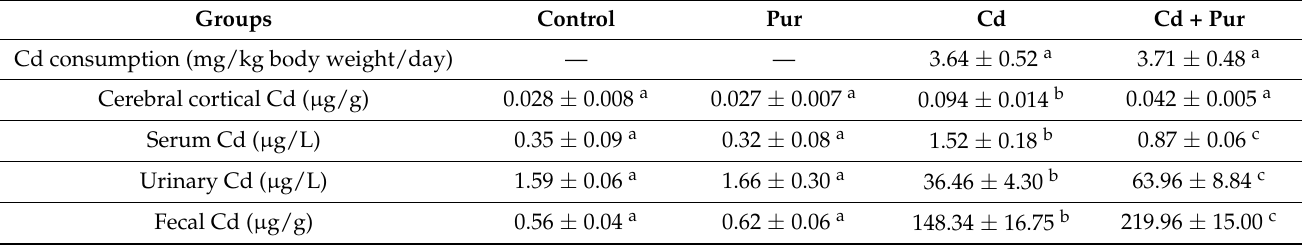
Table 1. Average daily Cd consumption and Cd concentrations in the cerebral cortex, serum, urine, and feces of the rats.